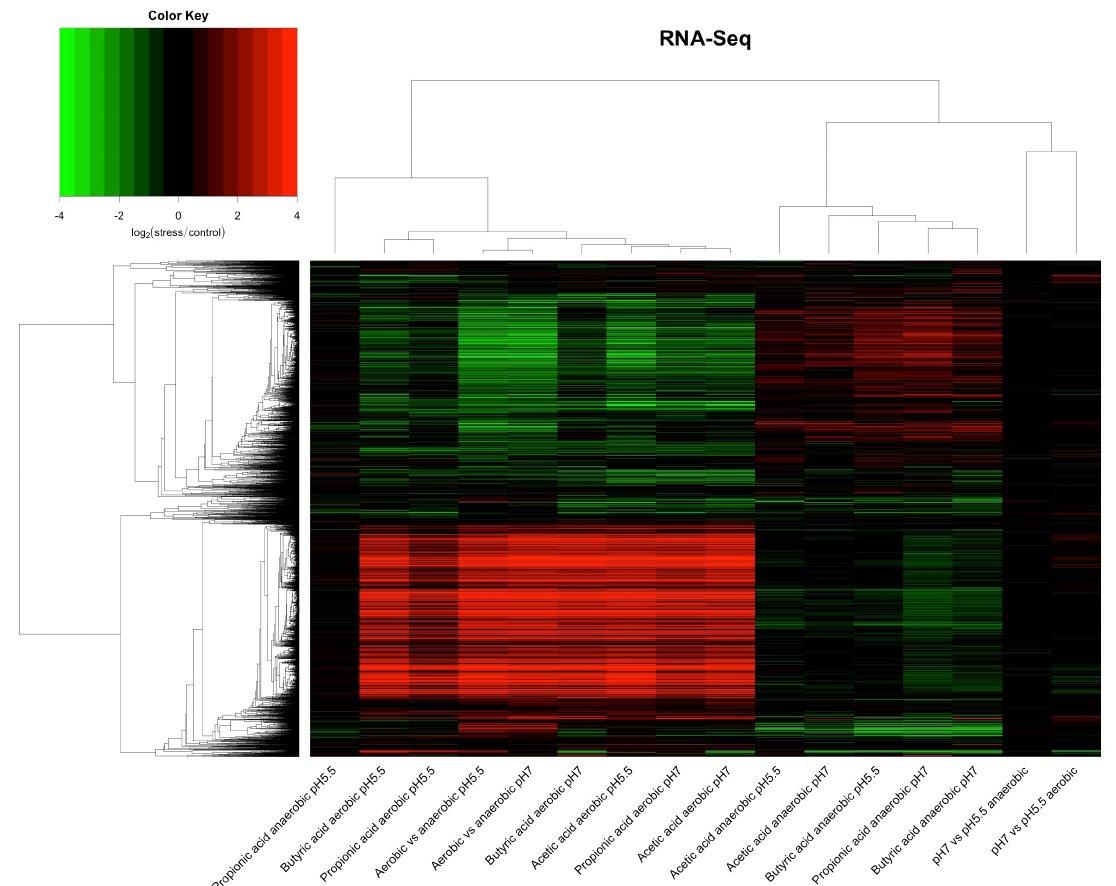
Figure 1. Cluster analysis of RNAseq data. RNAseq data were calculated as log 2 fold change (stress condition/control) for all conditions. Log 2 fold change values for all genes (excluding ribosomal RNA and small RNAs) were clustered as described in Materials and Methods. Conditions are shown on the x axis. Red and green indicate, respectively, a higher or lower expression under the stress than in the corresponding